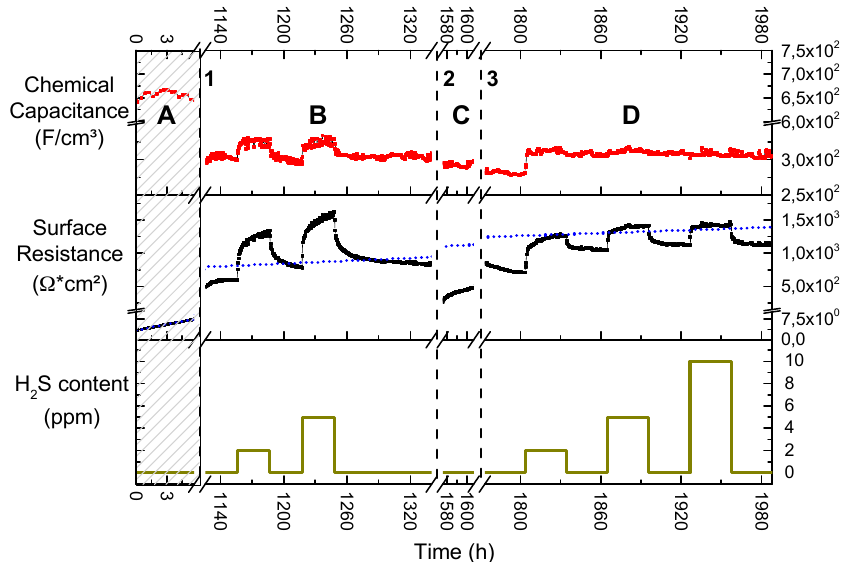
Figure 8. Evolution of chemical capacitance and surface resistance during a long-term measurement of a 300 µm diameter Pt/GDC 10 circular model-composite microelectrode at 750 °C. The atmosphere was 2.5% vol H 2 in Ar with a hydrogen to water ratio of 1:1; the H 2 S content is plotted in the bottom diagram. In the shaded region, labelled A , the plotted data stem from a different electrode on the same but pristine sample. The data in regions B , C and D were all recorded on the same electrode. During the first break in the time-axis, labelled 1, the sample was exposed to 10 ppm H 2 S for a week. During break 2, the electrode was polarised at +0.2 V for 10 days. During break 3, measurements were paused for a week at room temperature. The dotted blue line in the resistance—time plot is an extrapolation of the linear degradation encountered on the pristine sample plotted in region A .